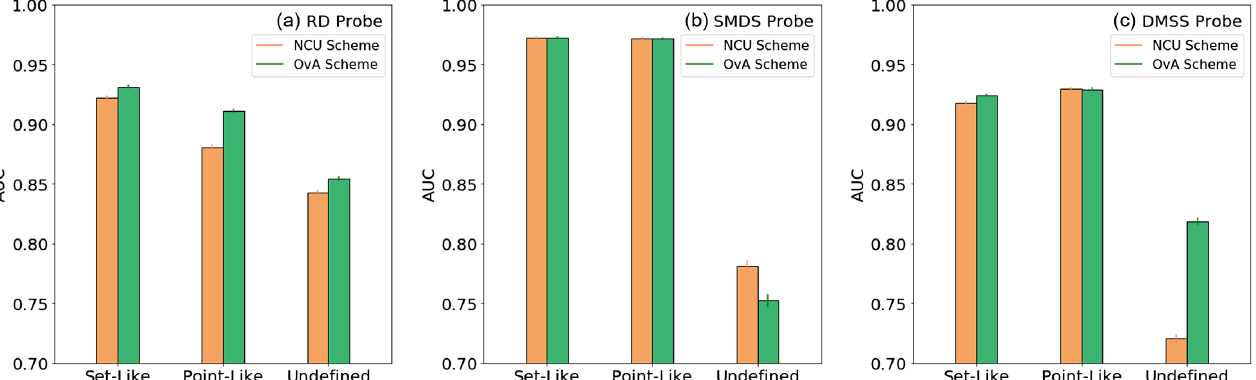
FIG. 7. AUC values and 95% confidence intervals (error bars) comparing the AUC of the NCU scheme to the one-vs-all (OvA) classification scheme. These results were determined from 500 different splits of the data into training and testing sets, and indicate whether the NCU scheme performs differently than the one-vs-all scheme.